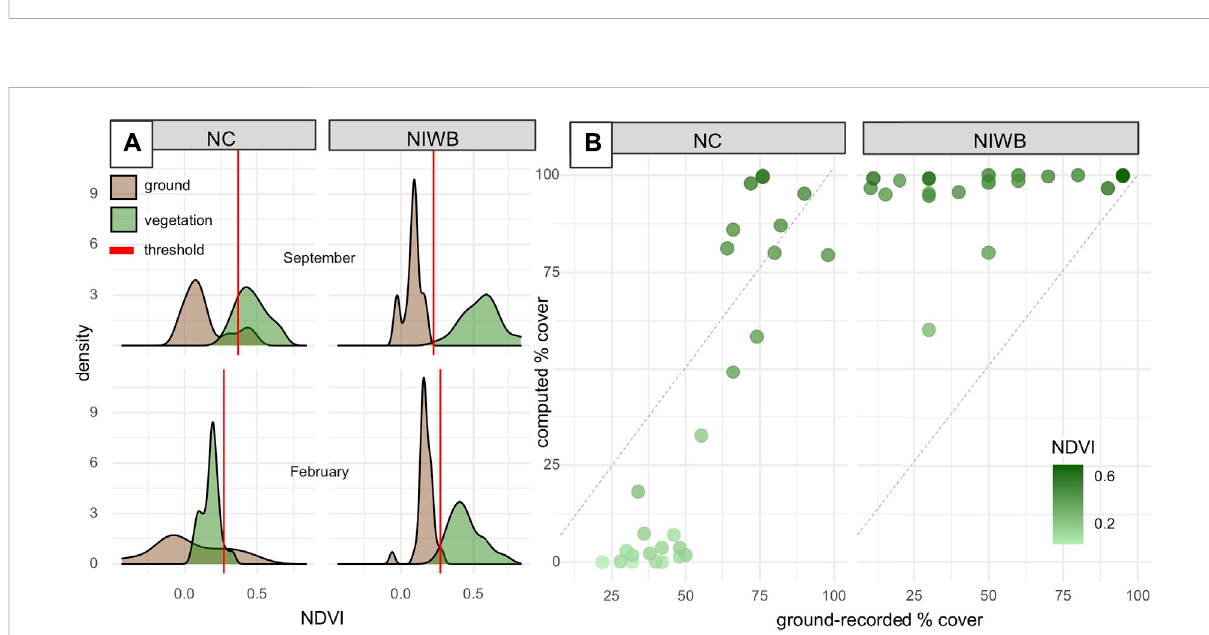
FIGURE 8 Percent cover estimates. (A) An NDVI threshold, denoted in red, is used to distinguish between ground and vegetation. (B) Computed percent cover estimates are compared to ground-recorded data, demonstrating weak alignment. Example sampling plots projected onto site orthomosaics are included. Points are colored by ground-recorded canopy height values within a sampling plot. Dashed lines represent the identity